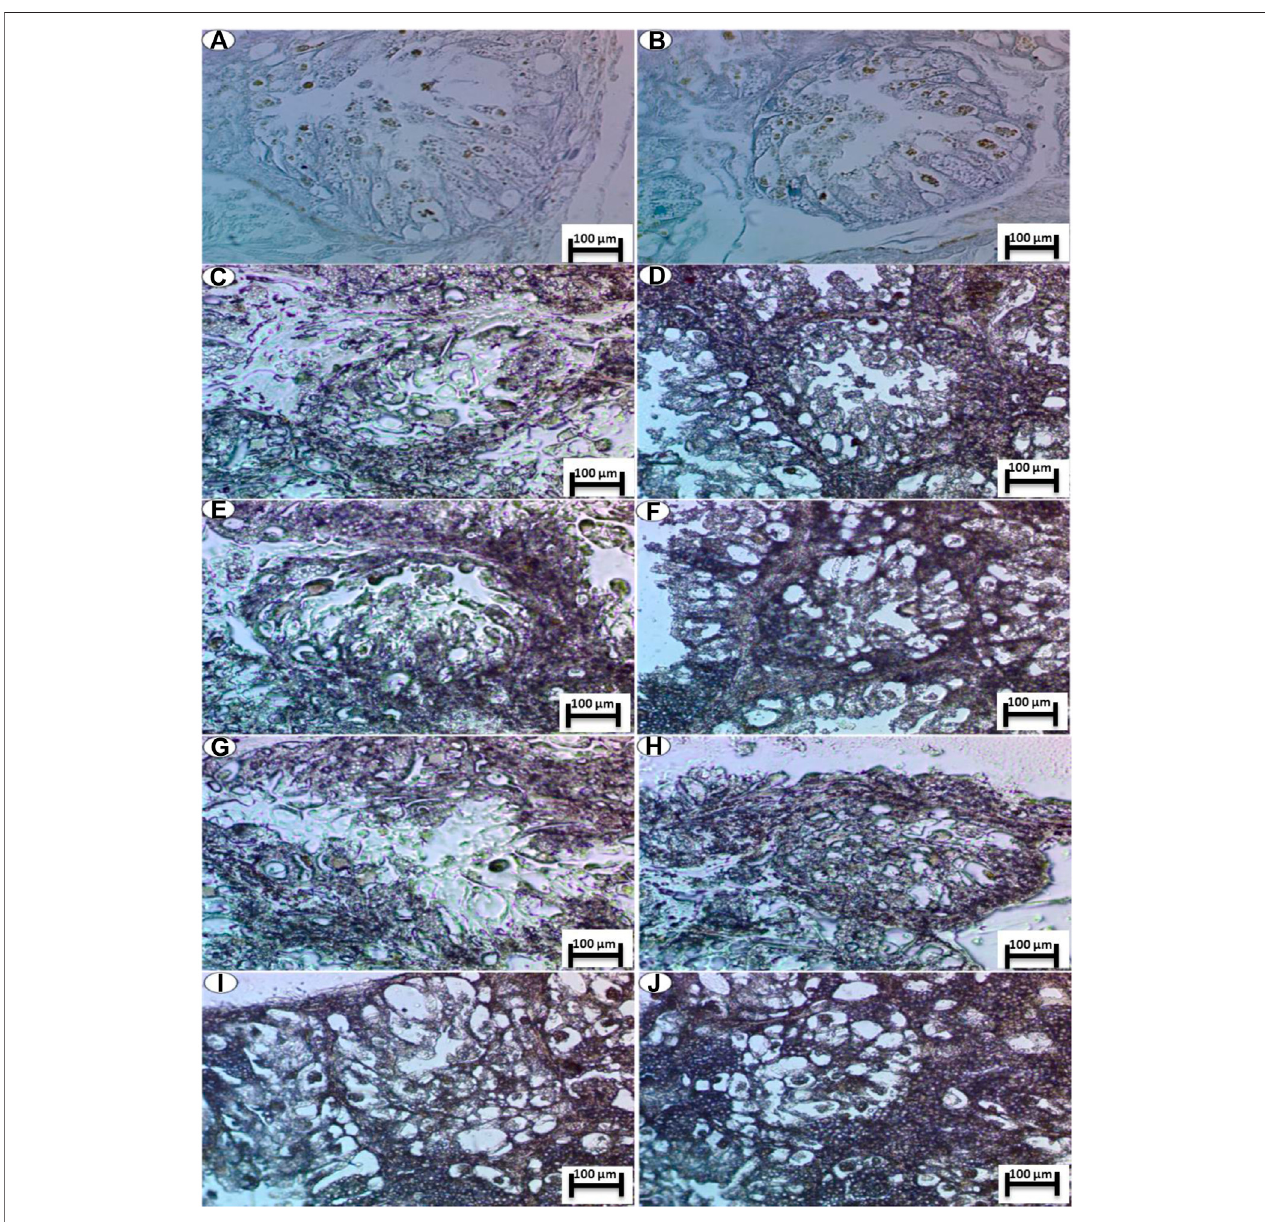
FIGURE6| Photomicrograph ofdigestive gland ofSlug Lehmannianyctelia after the exposure to (A,B) Control group, (C) ;0.04 g/LofAgNPs, (D) ;0.08 g/LofAg NPs, (E) ; 0.4 g/Lof Ag NPsand (F) ; 0.8 g/L of AgNPs, (G) ; 0.04 g/L of silver nitrate, (H) ; 0.08 g/L ofsilver nitrate, (I) ; 0.4 g/L of silver nitrate, (J) ; 0.8 g/L ofsilver nitrate. (Sudan black, scale bar 100 μ